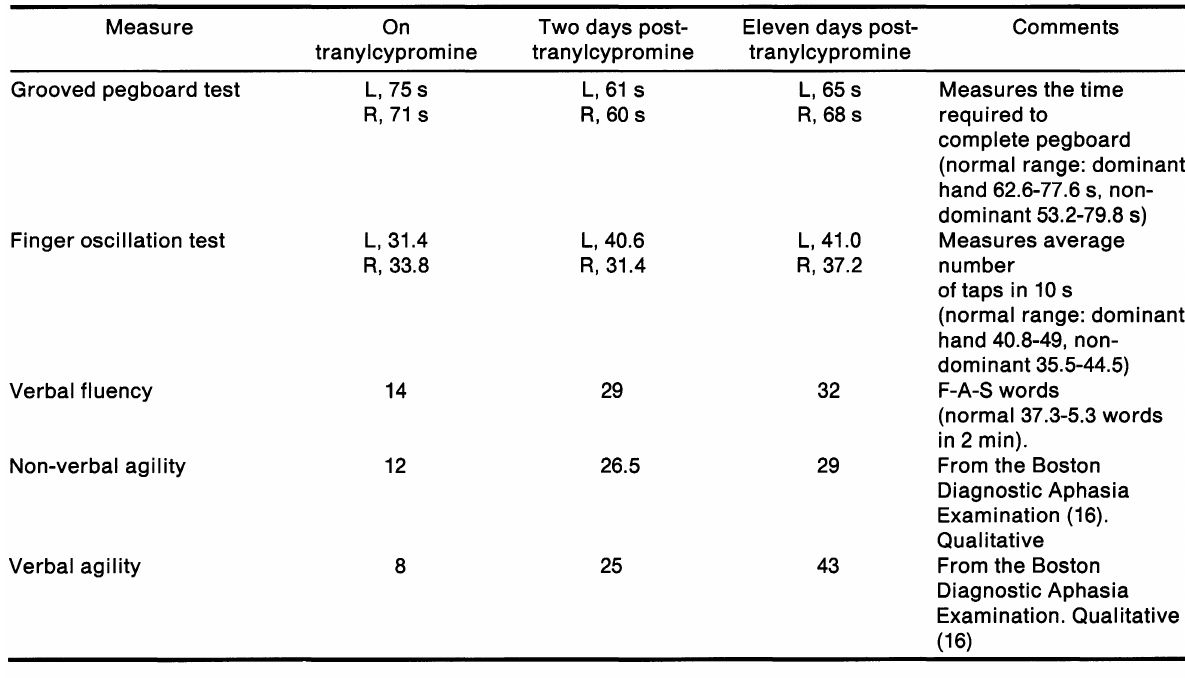
TABLE I. Patient's speech productivity and lateralizing hand motor function on and off